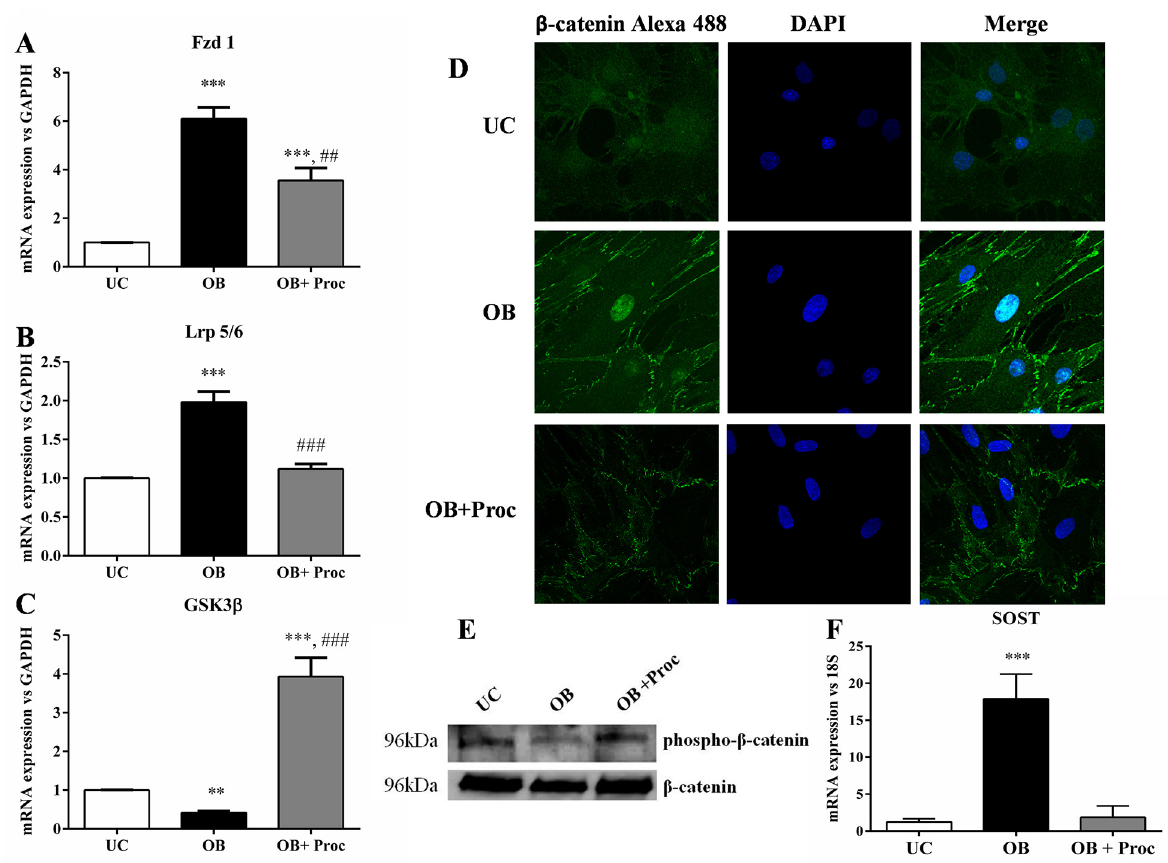
Fig 4. Procaine down-regulates Wnt/ β - catenin pathway during osteo/odontogenesis of MSC. Osteo/odontoblast stimulus (OB) increased the mRNA expression of A) Lrp5/6 and B) Frizzled 1 and decreased the mRNA expression of C) Gsk3 β ( *** p < 0.05 vs. undifferentiated cells, UC. Treatments with procaine (OB+Proc) decreased expression of Lrp5/6 and Frizzled 1 and increased expression of Gsk3 β (### p < 0.001 vs OB cells and ## p < 0.01 vs OB cells). D) Rat mesenchymal stem cells treated with osteo/ odontoblasts stimulus (OB) or osteo/odontoblasts stimulus plus procaine (OB+Proc) were stained for β -catenin immunofluorescence (green) and counterstained with DAPI (blue) to determine β -catenin subcellular localization. Merged images of β -catenin immunofluorescence and DAPI staining are shown. Original magnification: 40x. Images were representatives of three independent experiments. E) phospho- β -catenin analysis by western blot showed that osteo/odontogenesis of MSC leads to a decrease of this protein while the presence of Procaine recovered the cytoplasmic levels of phospho β -catenin after 21 days of culture. Images are representative of three cultures. F) mRNA expression of sclerostin was decreased by osteo/odontoblast stimulus (OB) (p < 0.05 vs UC) while procaine administration significantly increased the expression of this inhibitor (p < 0.05 vs OB). Ribosomal 18S expression was used as